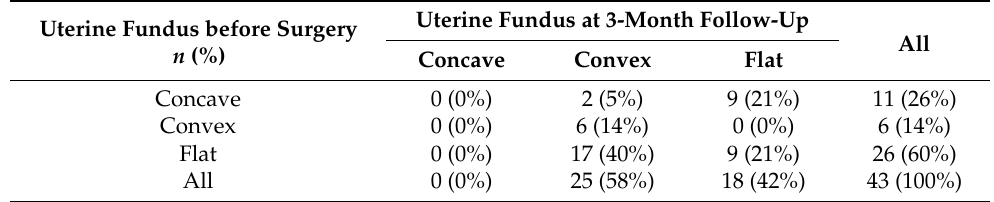
Table 3. Shape of the uterine fundus before surgery and at three-months evaluation after surgery in patients scheduled for a second-step surgery ( n = 43).